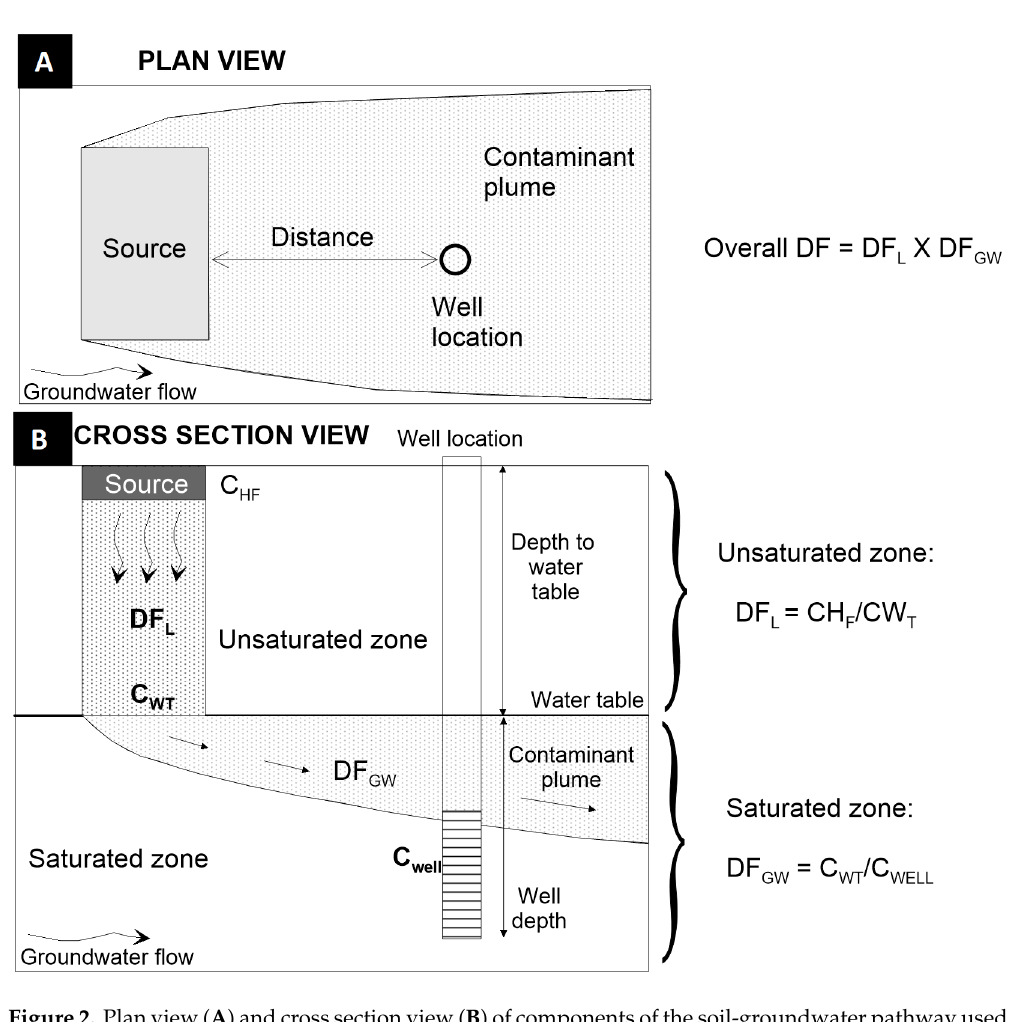
Figure 2. Plan view ( A ) and cross section view ( B ) of components of the soil-groundwater pathway used to assess solute migration from storage ponds via soil and groundwater pathways. Each component provides a set of computational endpoints. For derivation of dilution factors for unsaturated and saturated zone, see the main text [45].